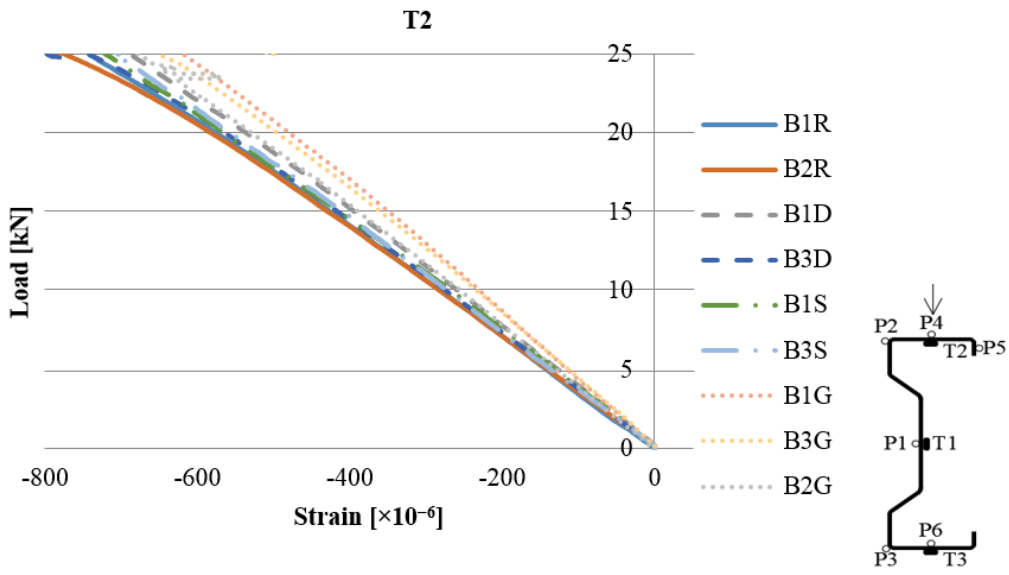
Figure 7. Load–strain diagram based on the reading from the T2 strain gauge.